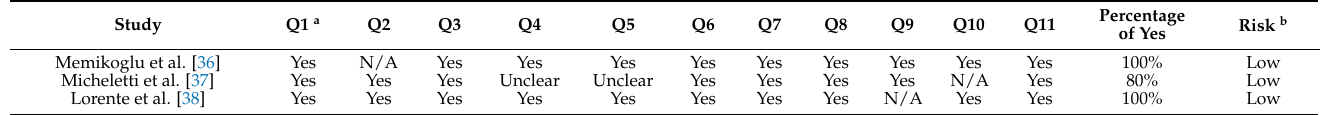
Table 3. JBI risk-of-bias quality assessment for cohort